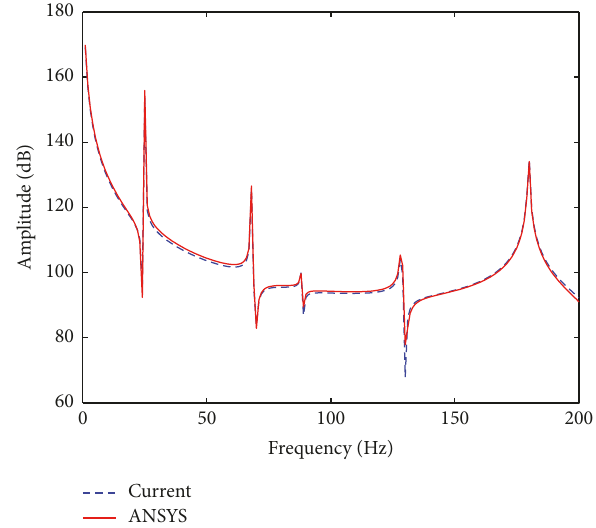
Figure 13: The response of the circular plate subjected to a normal point